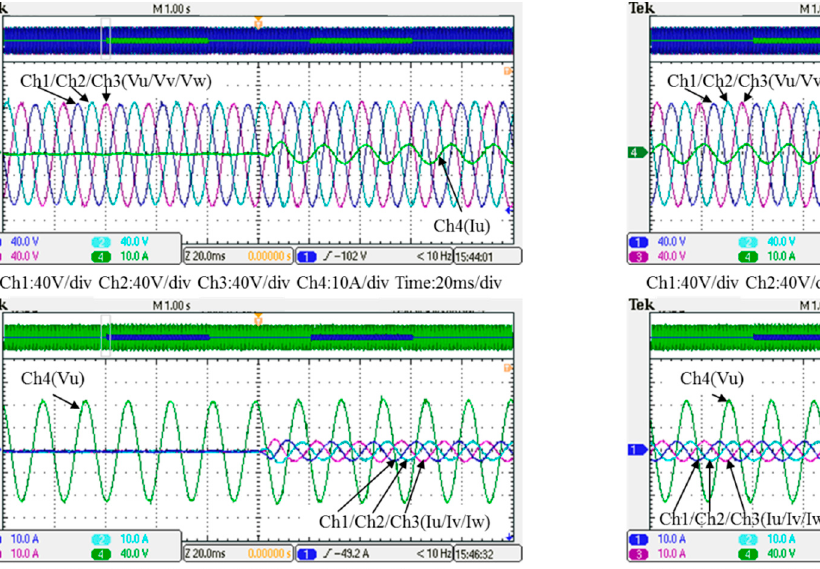
Figure 25. Case 1 implementation result: three-phase voltages and currents.